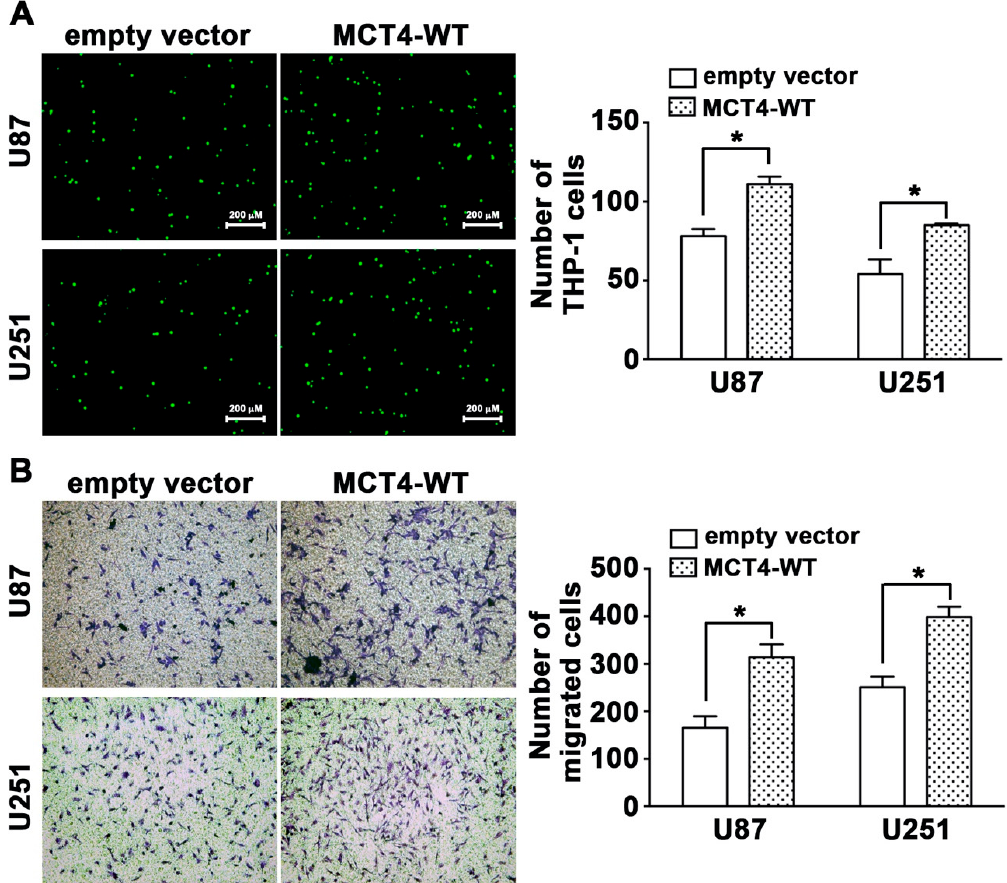
Figure 4. Overexpression of MCT4 enhances monocyte adhesion and GBM migration. U87 and U251 cells were transfected with either an empty vector or wild-type MCT4 for 24 h and were exposed to hypoxic conditions (1% O 2 ) for 24 h. (A) quantification of monocyte adhesion ability (right panel) was quantified using fluorescence microscopy. (B) GBM migration activity (right panel) was quantified using a digital camera. * p < 0.05 compared with the empty vector group (Student’s t -test). Quantitative data are presented as the mean ± S.E.M. ( n = 3).